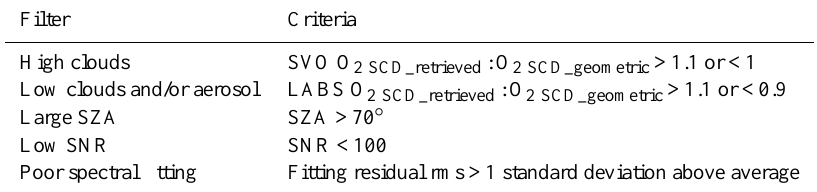
Table 2. Data filter criteria.